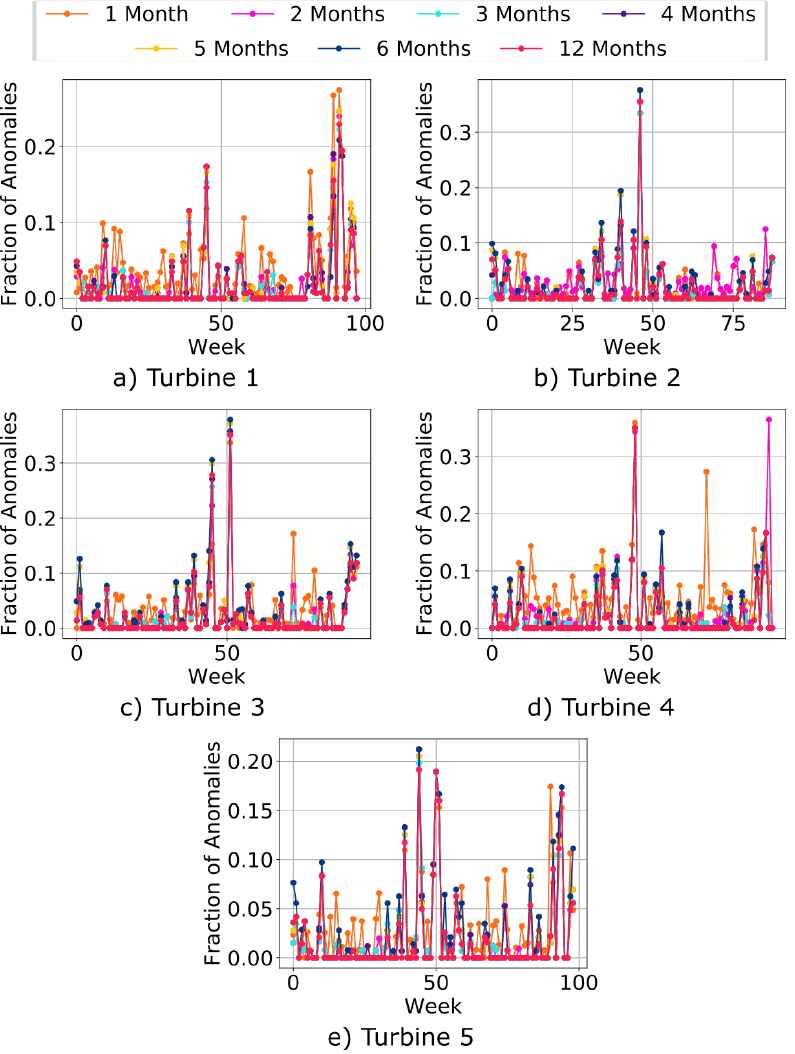
Figure 8. Weekly Anomaly proportions for Case Study 2 without Hydraulic Oil